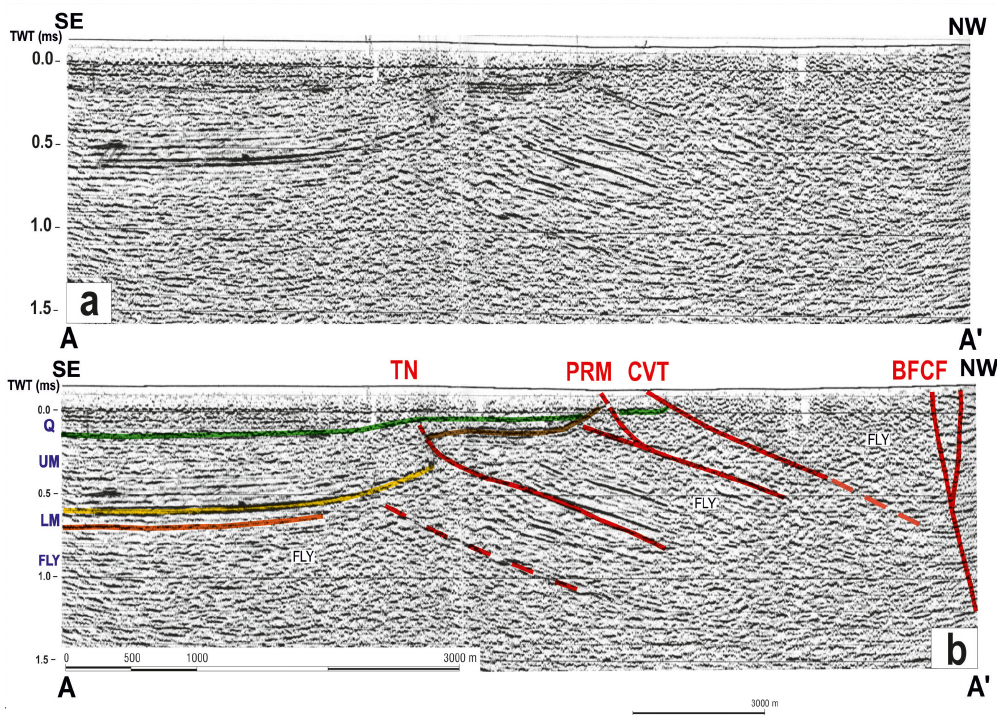
Figure 2. (a) Reflection seismic section crossing the study area; (b) interpretation (line drawing) of the reflection seismic section (A–A (cid:48) in Fig. 1b). Q: Quaternary; UM: Middle–Upper Miocene Molasse; LM: Cavanella Group (Lower–Middle Miocene); FLY: Upper Cretaceous– Lower Eocene p.p. turbiditic